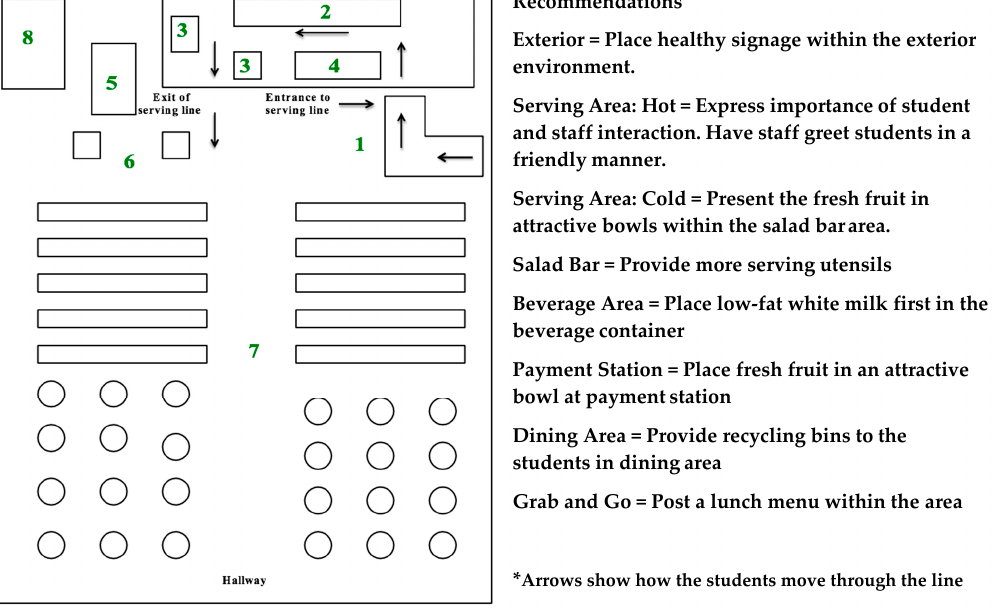
Figure 1. Recommendation report to improve NudgeSAT score at Site 2.